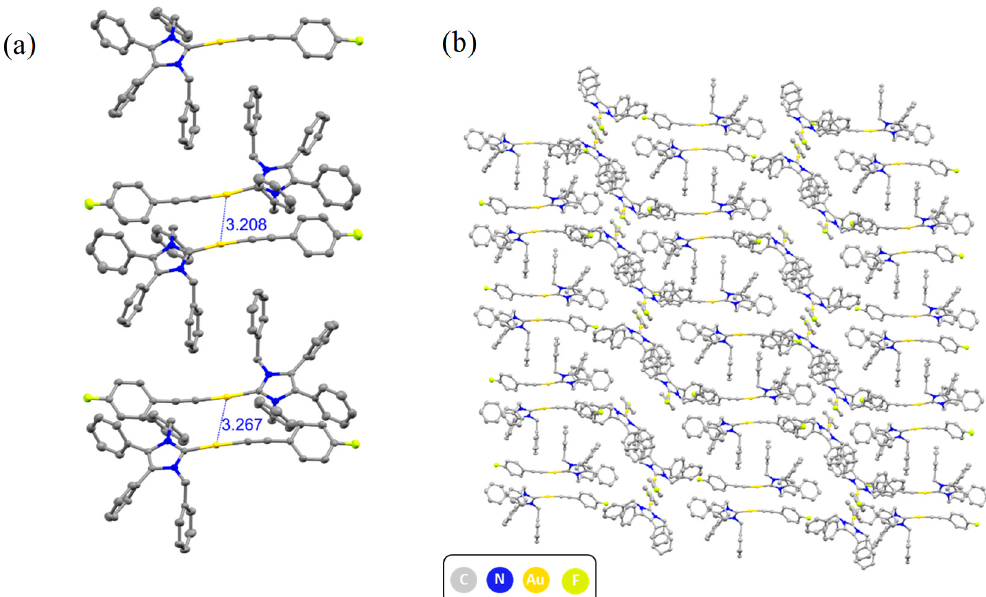
Figure 5. ( a ) A view along the chain of NHC*-Au-CC-Ph-F ( 5d ) molecules showing the distances (marked in blue) between the gold atoms (3.2077(9) and 3.2666(9) Å. ( b ) The crystal packing of 5d shows a pattern of parallel chains. Hydrogen atoms and solvent molecules are omitted for clarity.